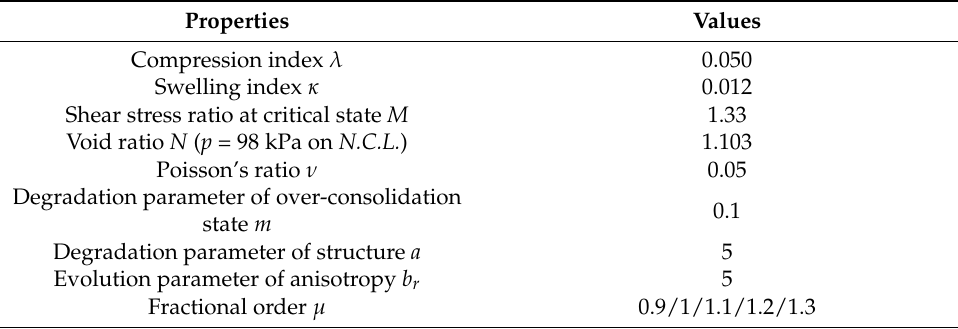
Table 1. Material parameters of Karlsruhe fine